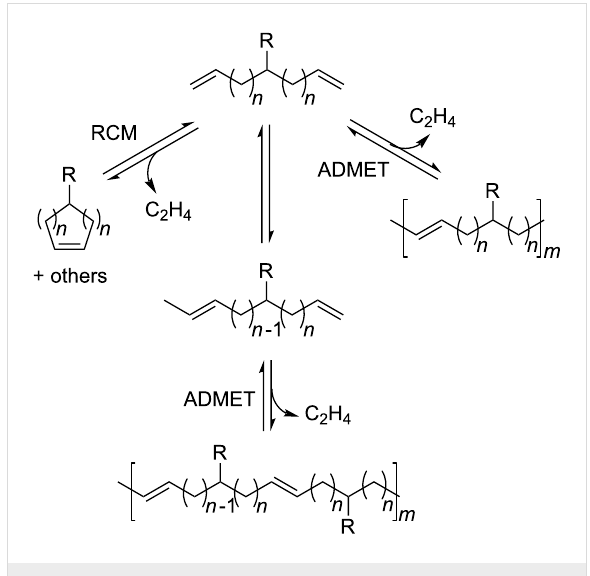
Figure 1: Olefin isomerization during ADMET polymerization.